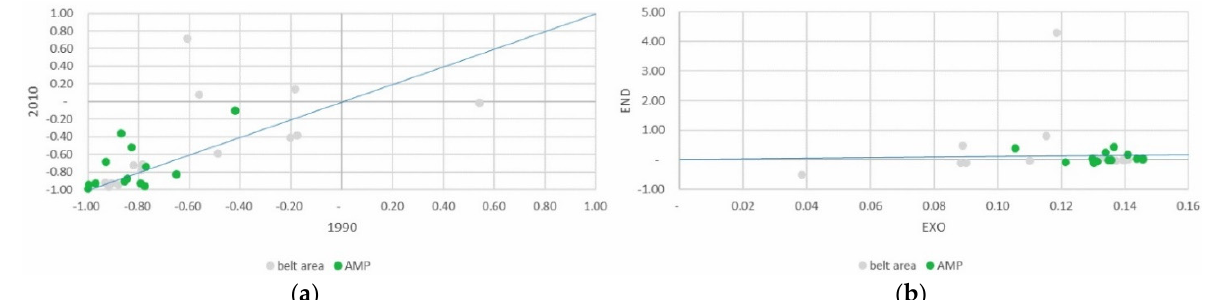
Figure 17. ( a , b ) PSI and DPSI for vegetables. Source: Drawn up by the authors using data provided by the ISTAT.